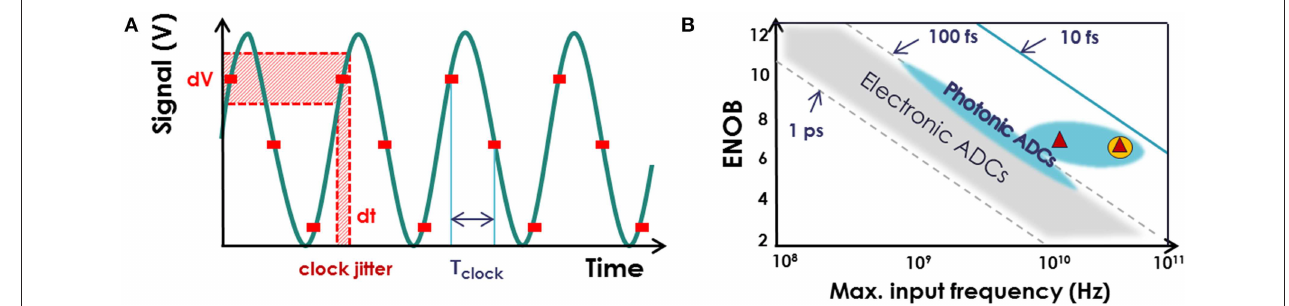
FIGURE 6 | (A) Illustration of the issue of clock time jitter on sampling resolution for high frequency signals: the time jitter dt is converted into a large amplitude uncertainty dV . T clock is the time period of the clock. (B) “Walden’s graph” showing ADCs performance in terms of maximum input frequency and resolution, depending on the time jitter of the clock. Oblique lines stand for performances with a given time jitter. ENOB, effective number of bits which codes for each binary digit after sampling and digitization. High ENOB means high resolution. Gray-shaded area represents reports from fully electronic systems, and blue-shaded areas from state-of-the-art photonic-assisted ADCs; photonic ADCs performances are taken from Khilo et al. [55] (yellow circle) and Ghelfi et al. [56] (red triangles). We can see that thanks to low time-jitter optical sources, photonic ADCs can go beyond electronic ADCs